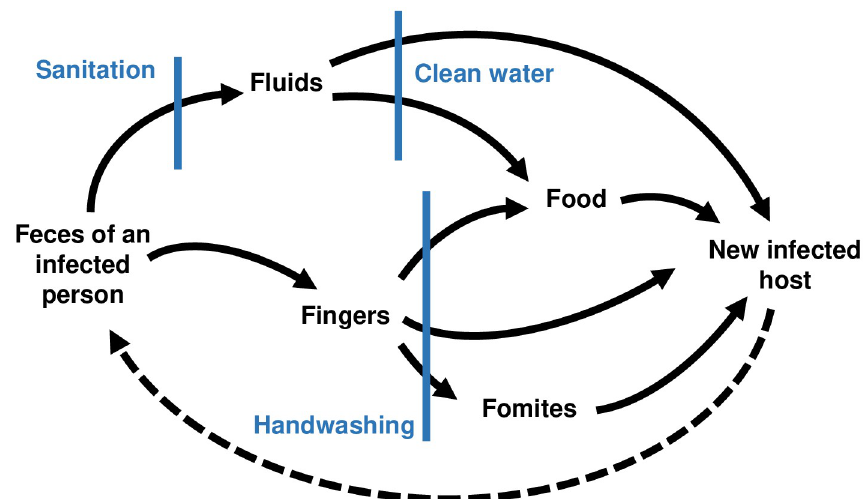
Fig 1. F-diagram. Simplified “F-diagram” illustrating different transmission pathways [7]. The blue bars show how specific types of interventions may interrupt transmission along these pathways. The dotted line (not traditionally included in the F-diagram), highlights that infected individuals continue to contribute to environmental